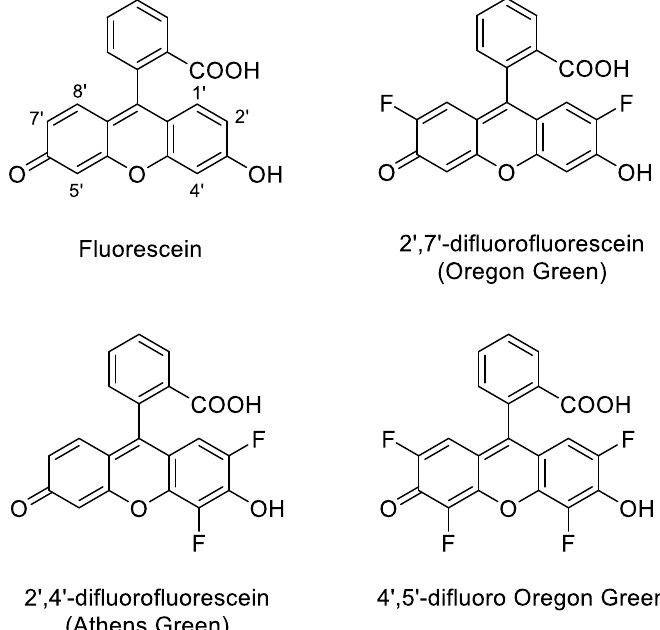
Figure 2. Chemical structures of the compounds investigated in this study. The standard numbering system for fluorescein is shown in the top